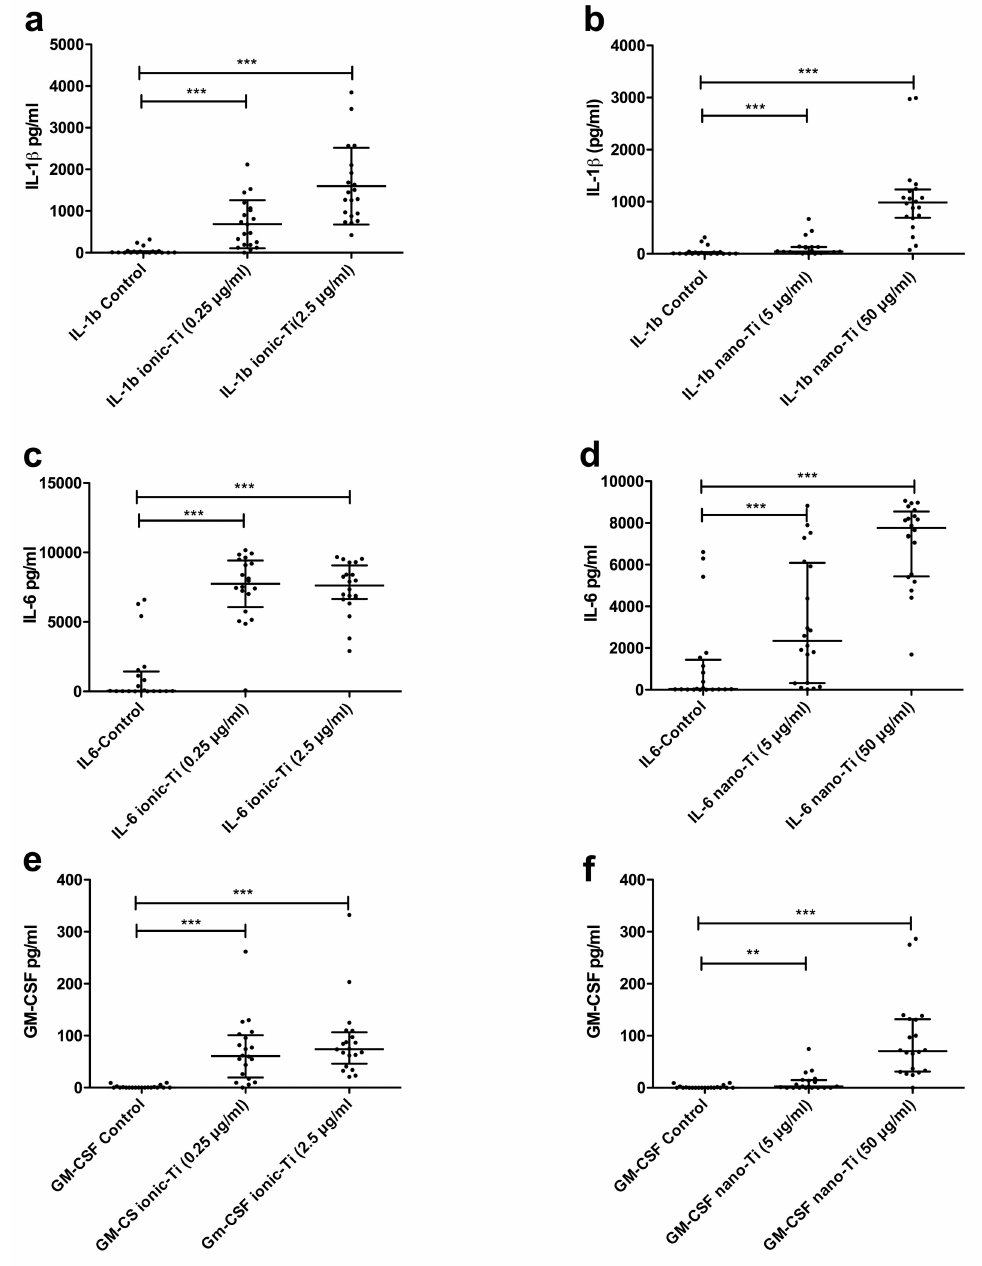
Figure 4. Expression levels of IL-1 β ( a , b ), IL-6 ( c , d ), and GM-CSF ( e , f ) were increased after stimulation with either nano-Ti or ionic-Ti for 24 h. Graphs show median and interquartile range ( N = 20). *** p < 0.0001, ** p < 0.01, * p <